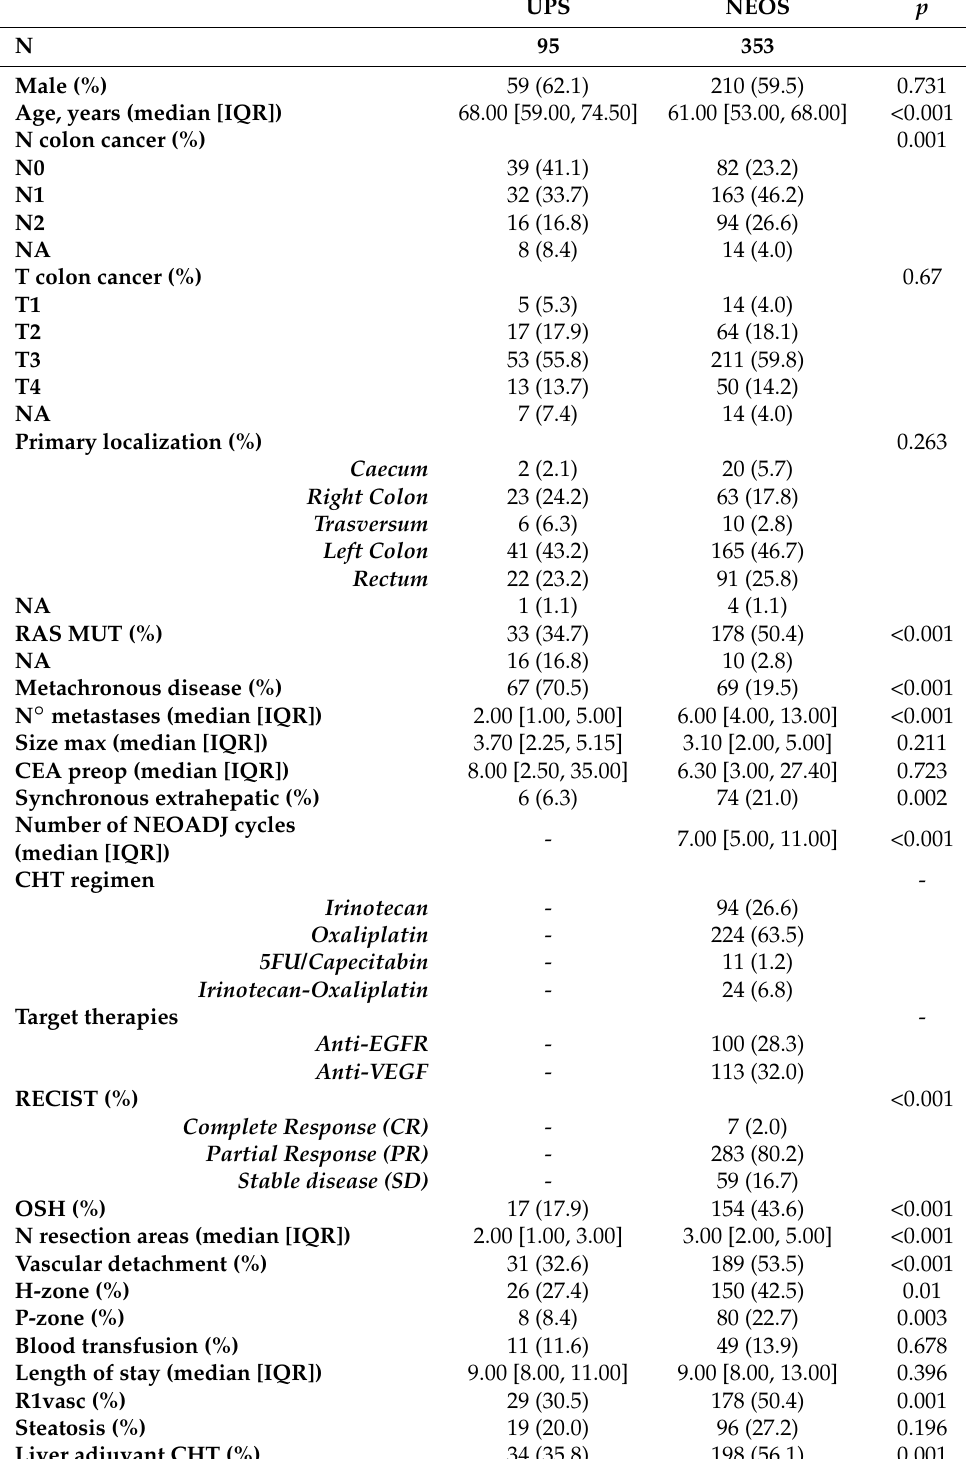
Table 1. Baseline characteristics of the cohort of patients